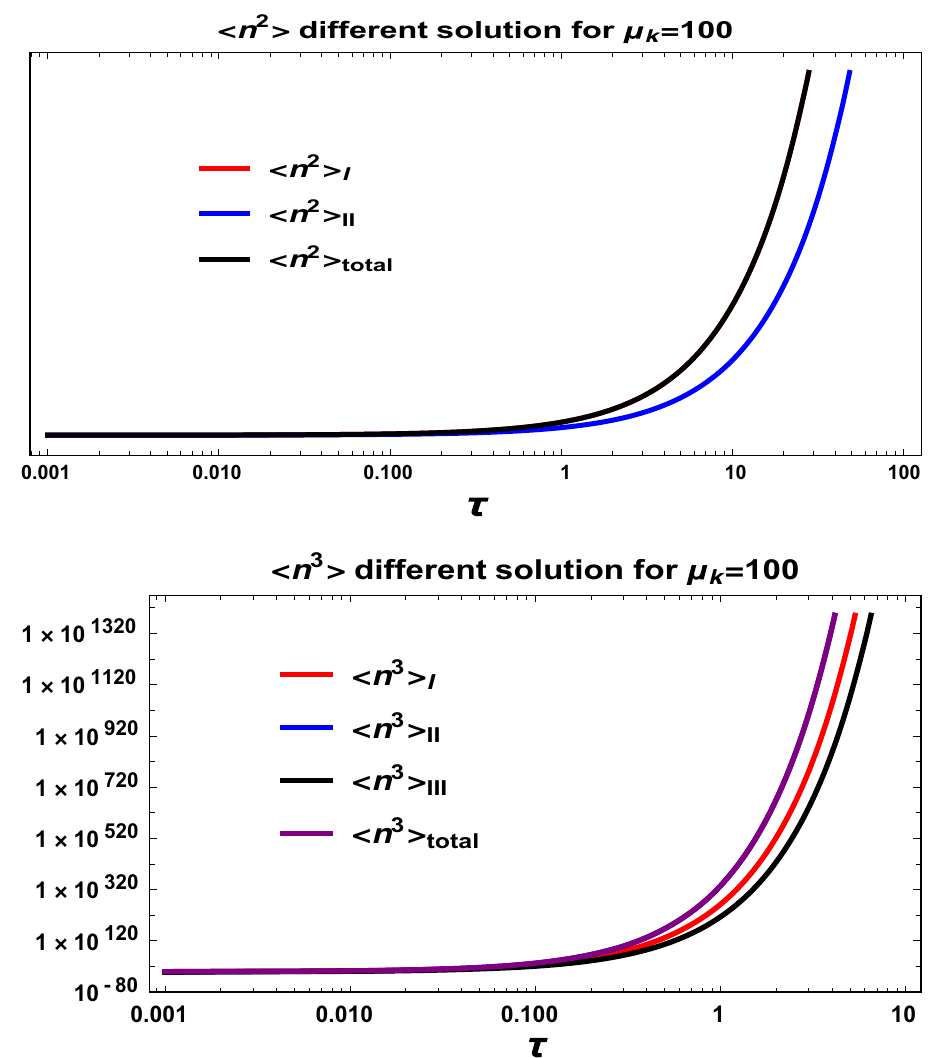
Fig. 49 Time dependent behaviour of different (cid:14) n 2 (cid:15) at different values of the parameter μ